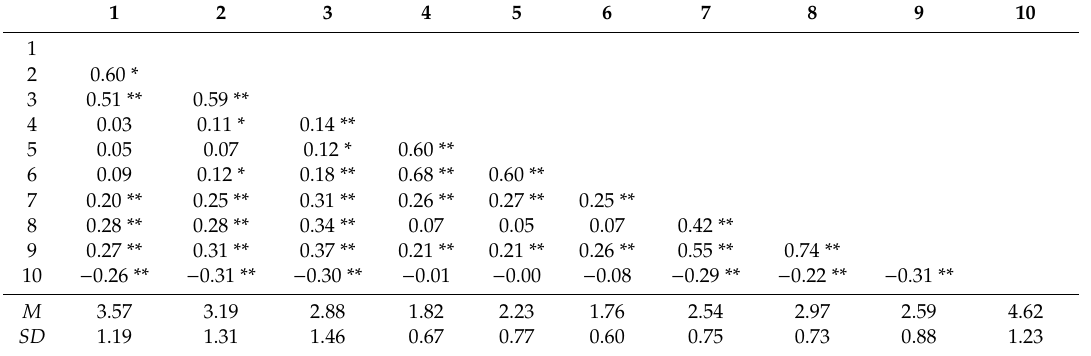
Table 3. Correlation, Mean ( M ), and standard deviation ( SD ) of subscales of CCBS, SAS-2, ABQ, and total